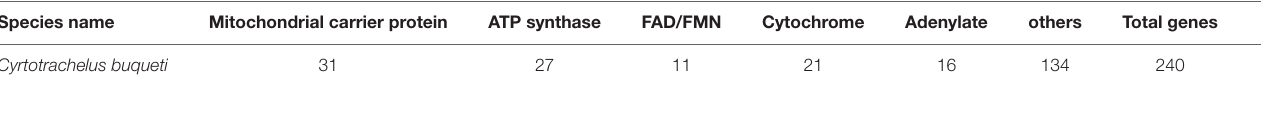
TABLE 5 | Statistical table of genes related to energy production and